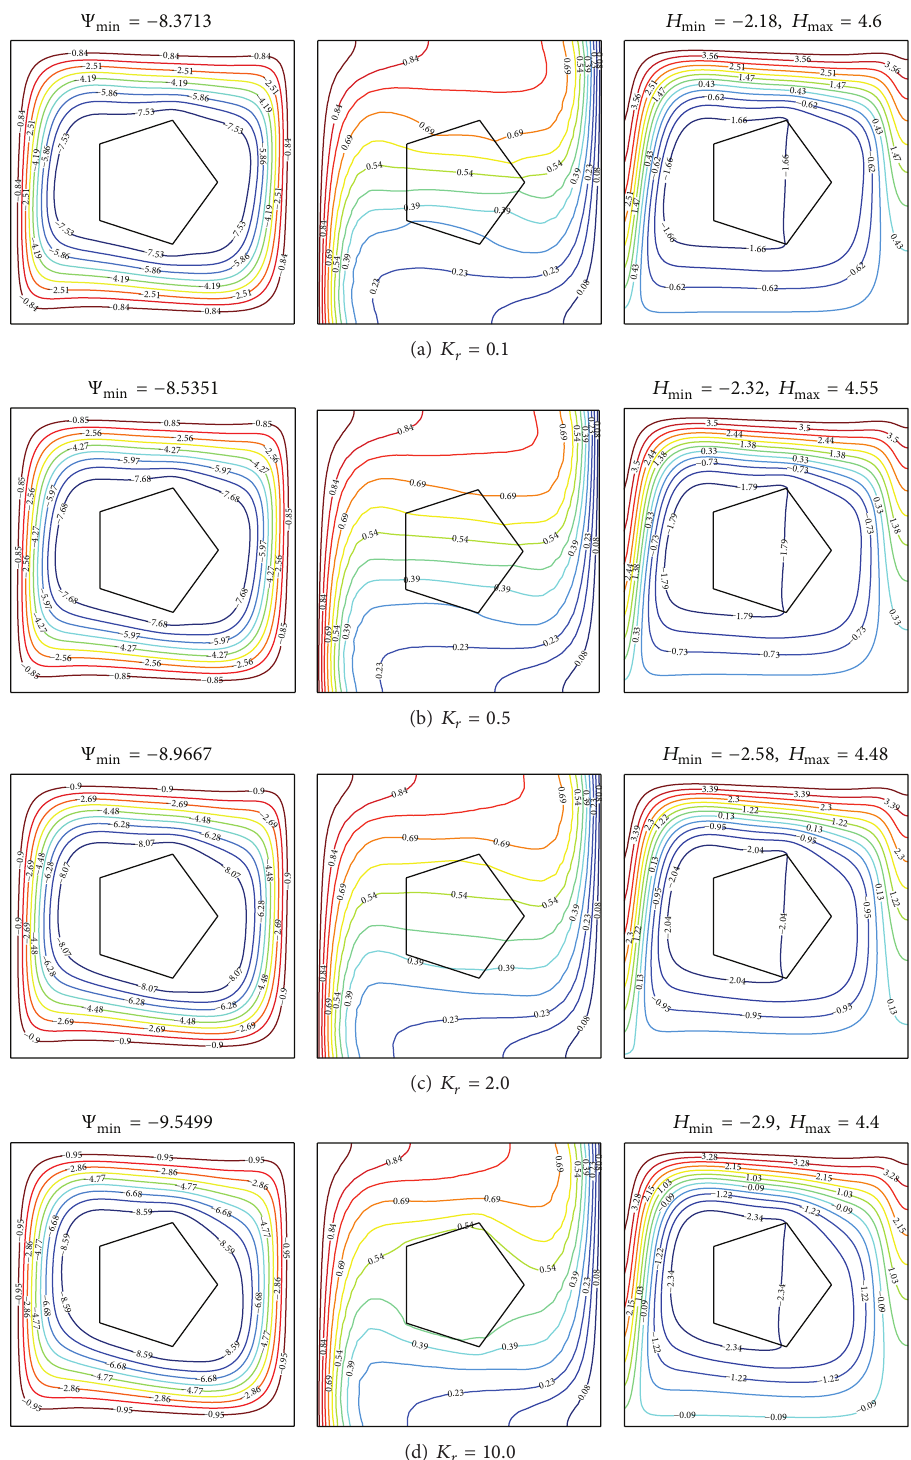
Figure 5: Streamlines (left), isotherms (middle), and heatlines (right) evolutions by varying thermal conductivity ratio for 𝑁 = 5 , 𝑋 0 = 0.5 , 𝐴 = 𝜋/25 , and Ra = 10 5